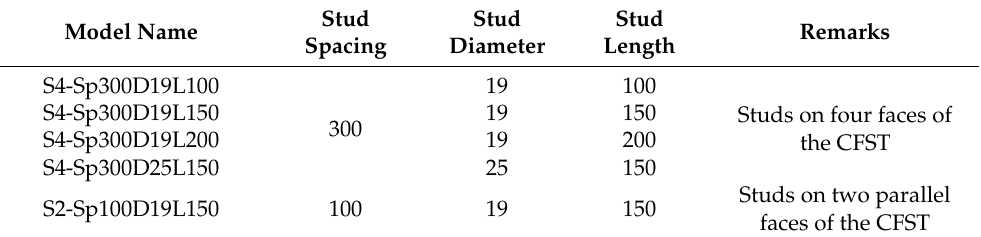
Table 1. List of finite-element models with shear stud connectors.